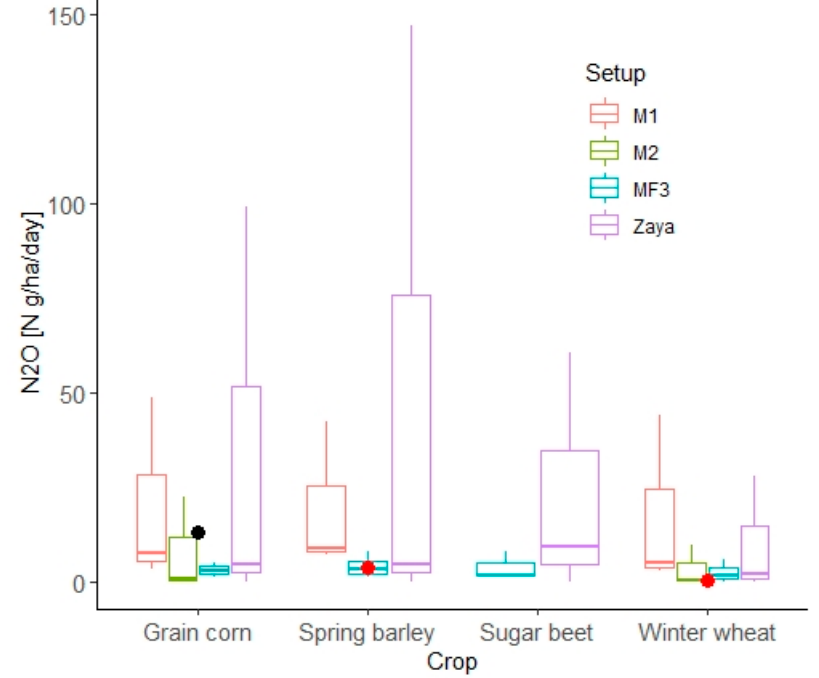
Figure 8. The comparison of average simulated daily N 2 O and average measured daily N 2 O during the growing season. The boxplot shows the median with hinges on the 25% and 75% quantiles. Black point indicates measured average daily N 2 O in Pötting. Red points indicate measured average daily N 2 O in Hirschstetten .